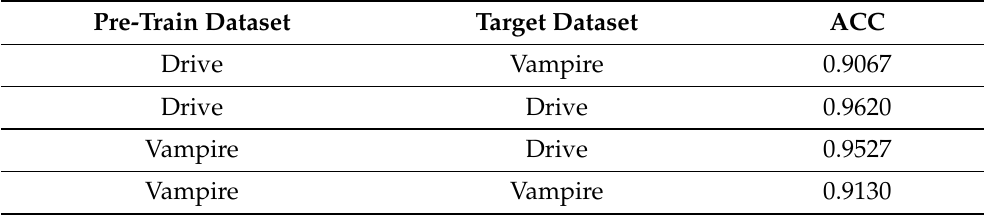
Figure 5. Experimental results. Table 2. Crossover